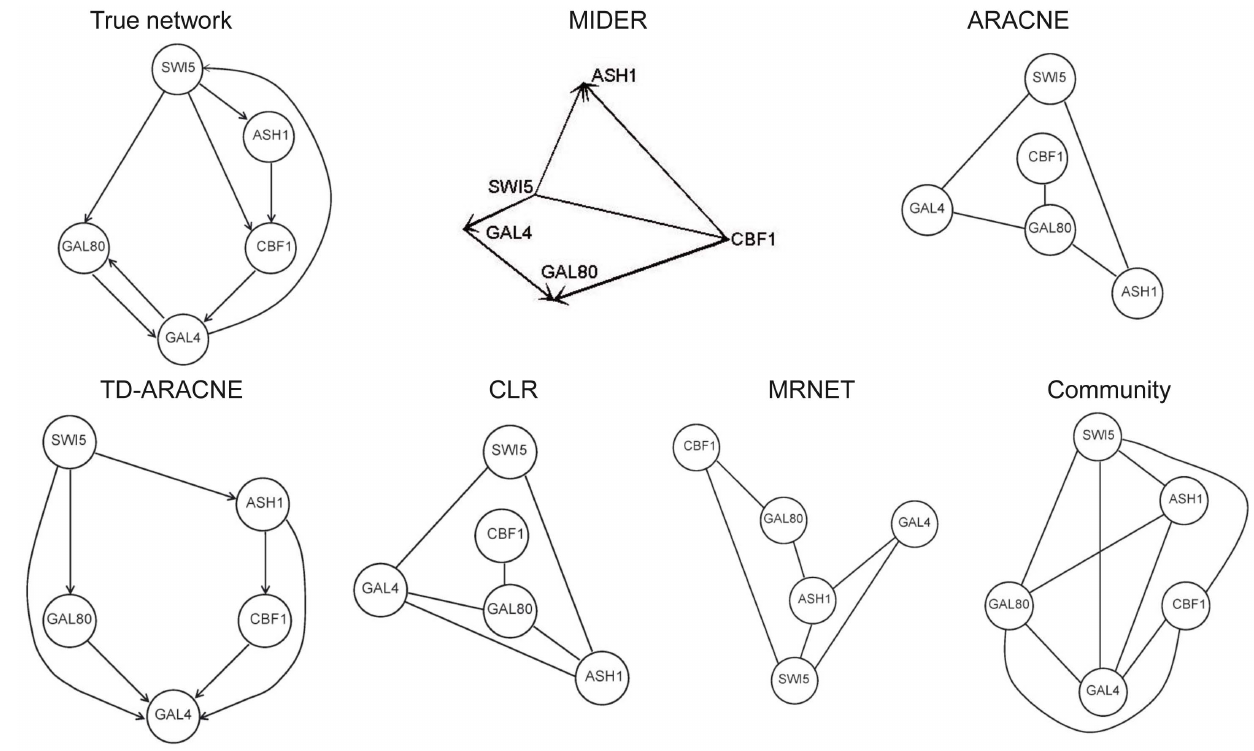
Figure 8. Benchmark B4. IRMA.